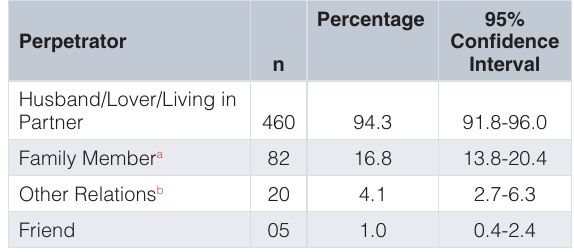
Table 5. Consequences following violence (n=488). Table 6. Types of perpetrators (n=488).